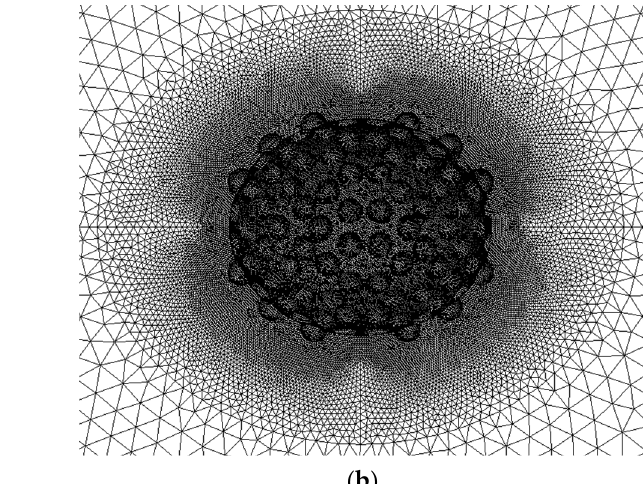
Figure 8. Detail views of computational grid, ( a ) TRI, ( b ) ASC (mesh in the symmetry plane is displayed, together with the mesh on the egg’s surface).